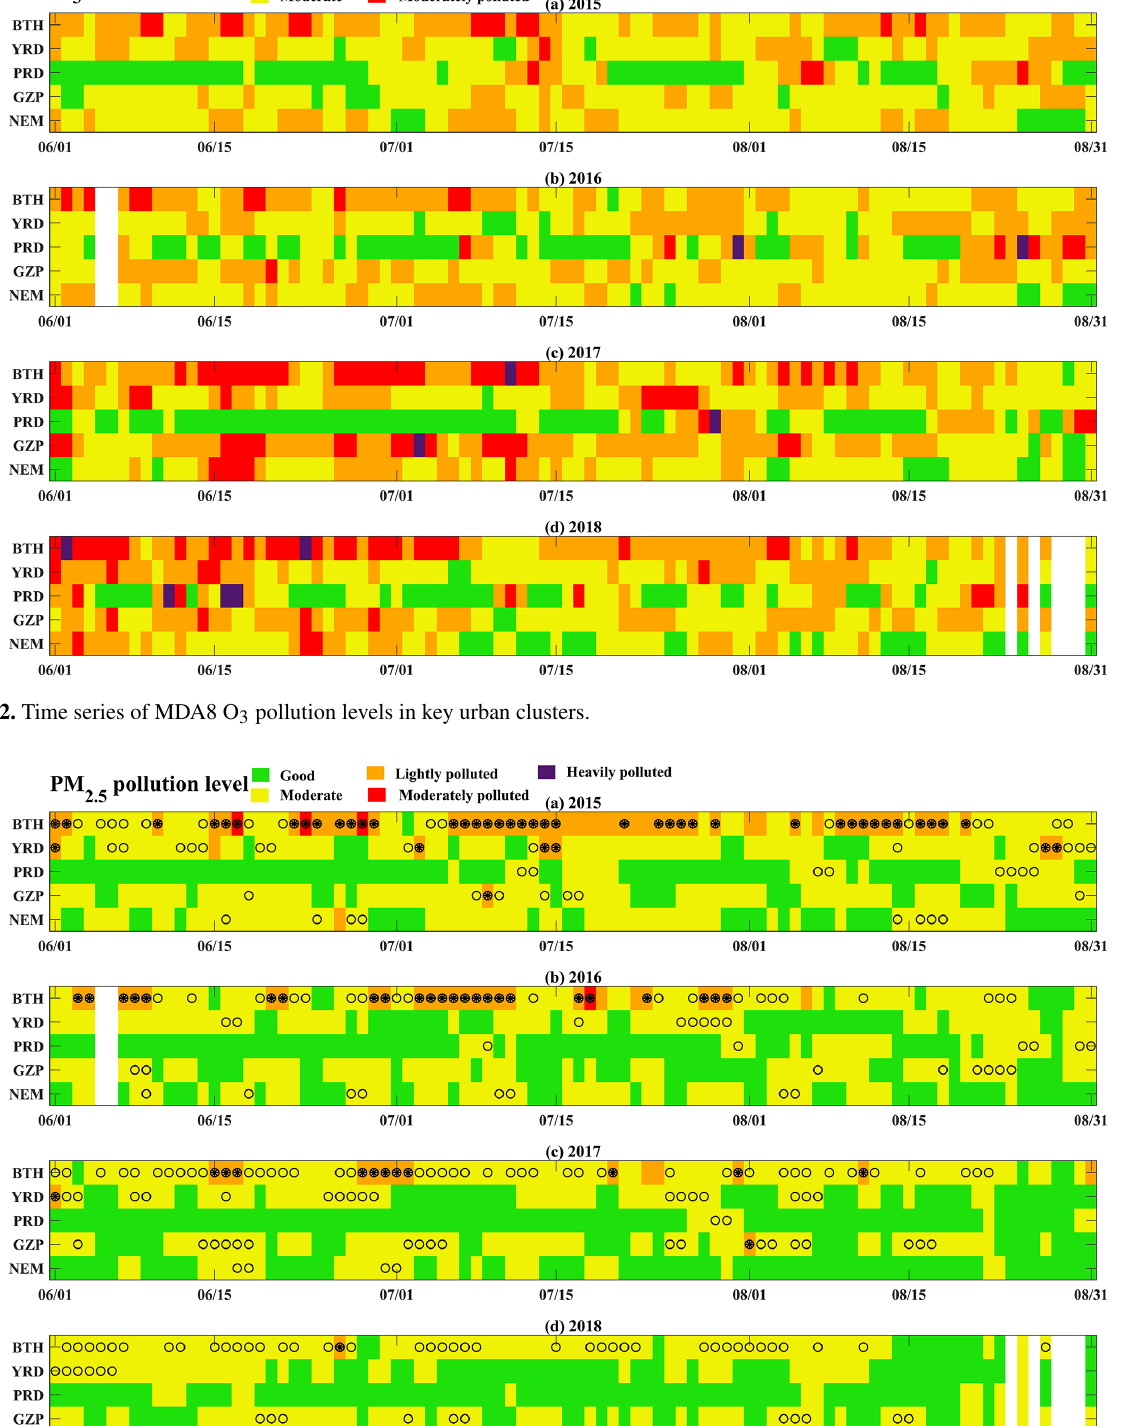
Atmos. Chem. Phys., 21, 9105–9124, 2021